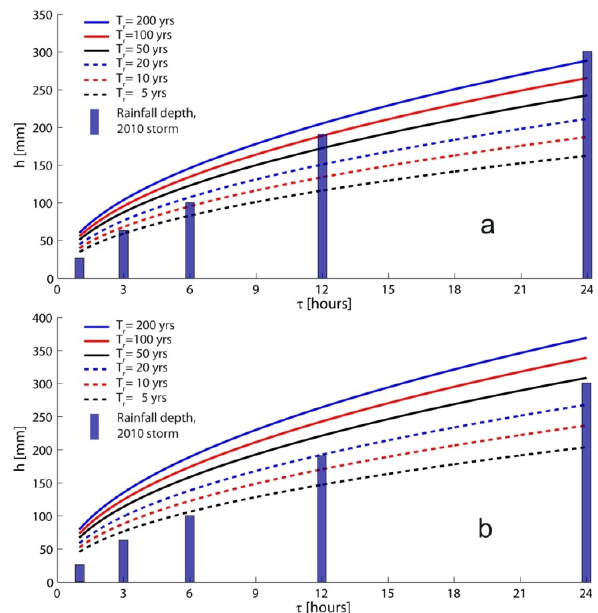
Fig. 3. Rainfall Depth-Duration-Frequency (DDF) curves deter- mined by using 1925–1975 (a) and 1990–2009 (b) data series for the Ceolati rainfall station, located close to Val di Maso. Blue bars indicate the maximum cumulative rainfall over 1, 3, 6, 12 and 24h during the November 2010 rainfall event.